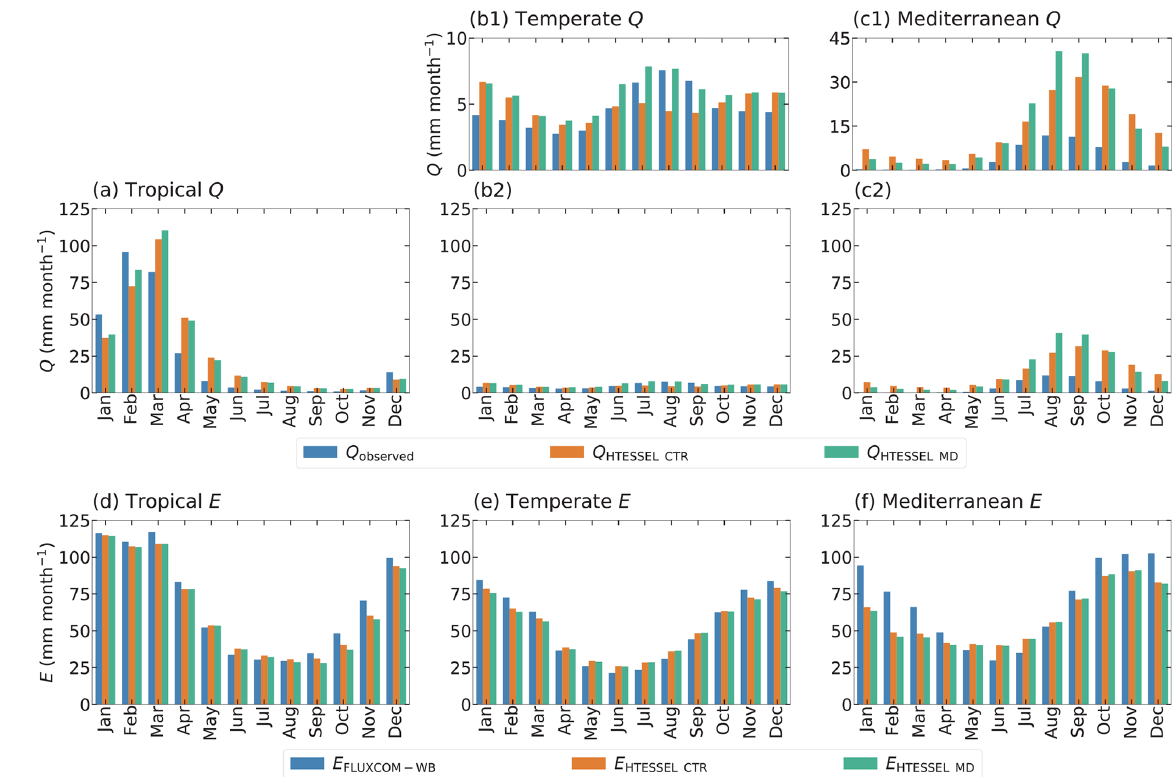
Figure 6. Monthly seasonal climatology of observed discharge ( Q ) (a–c) and FLUXCOM-WB evaporation ( E FLUXCOM-WB ) (d–f) as well as modeled values in the HTESSEL CTR and MD versions, averaged for the tropical (a, d) , temperate (b, e) and Mediterranean (c, f) catchments for the time series 1975–2010. Labels (b1) and (c1) represent the same data as in (b2) and (c2) , but with a different y axis. Similar illustrations for the individual catchments are shown in Figs. S1 ( Q ) and S2 ( E